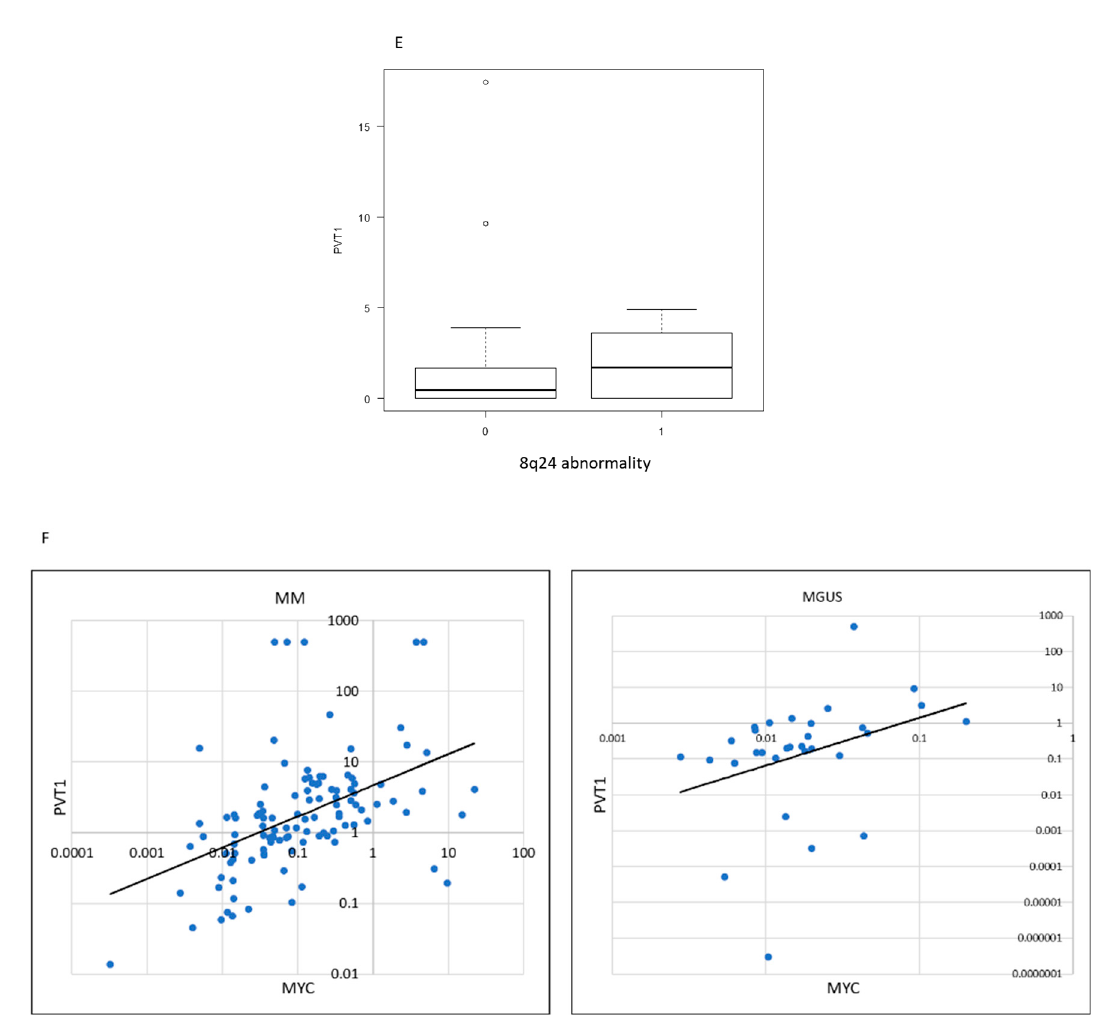
Figure 1. RNA expression determined using RQ-PCR in plasma cells isolated from bone marrow specimens, organized by patient status. Each dot represents a patient. RQ-PCR: real time quantitative PCR. MGUS: monoclonal gammopathy of undetermined significance. MM: multiple myeloma. ( A ) Plasmacytoma Variant Transcript 1 (PVT1), ( B ) MYC, and ( C ) PVT1 expression by international staging system (ISS). ( D ) PVT1 expression, according to karyotype, determined using fluorescence in situ hybridization (FISH). ( E ) PVT1 expression by chromosome 8q24 abnormality determined using FISH. ( F ) Correlation between PVT1 and MYC RNA expression in plasma cells of MM and MGUS.